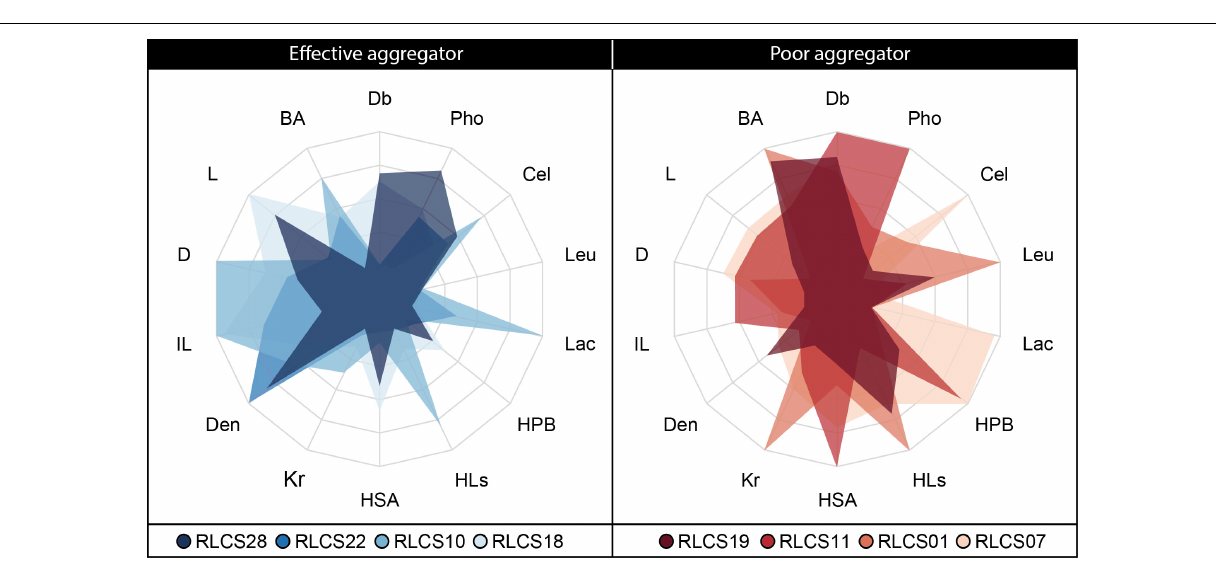
FIGURE 5 | Radar plot depicting trait expressions for the four best and four poorest soil aggregate forming fungal